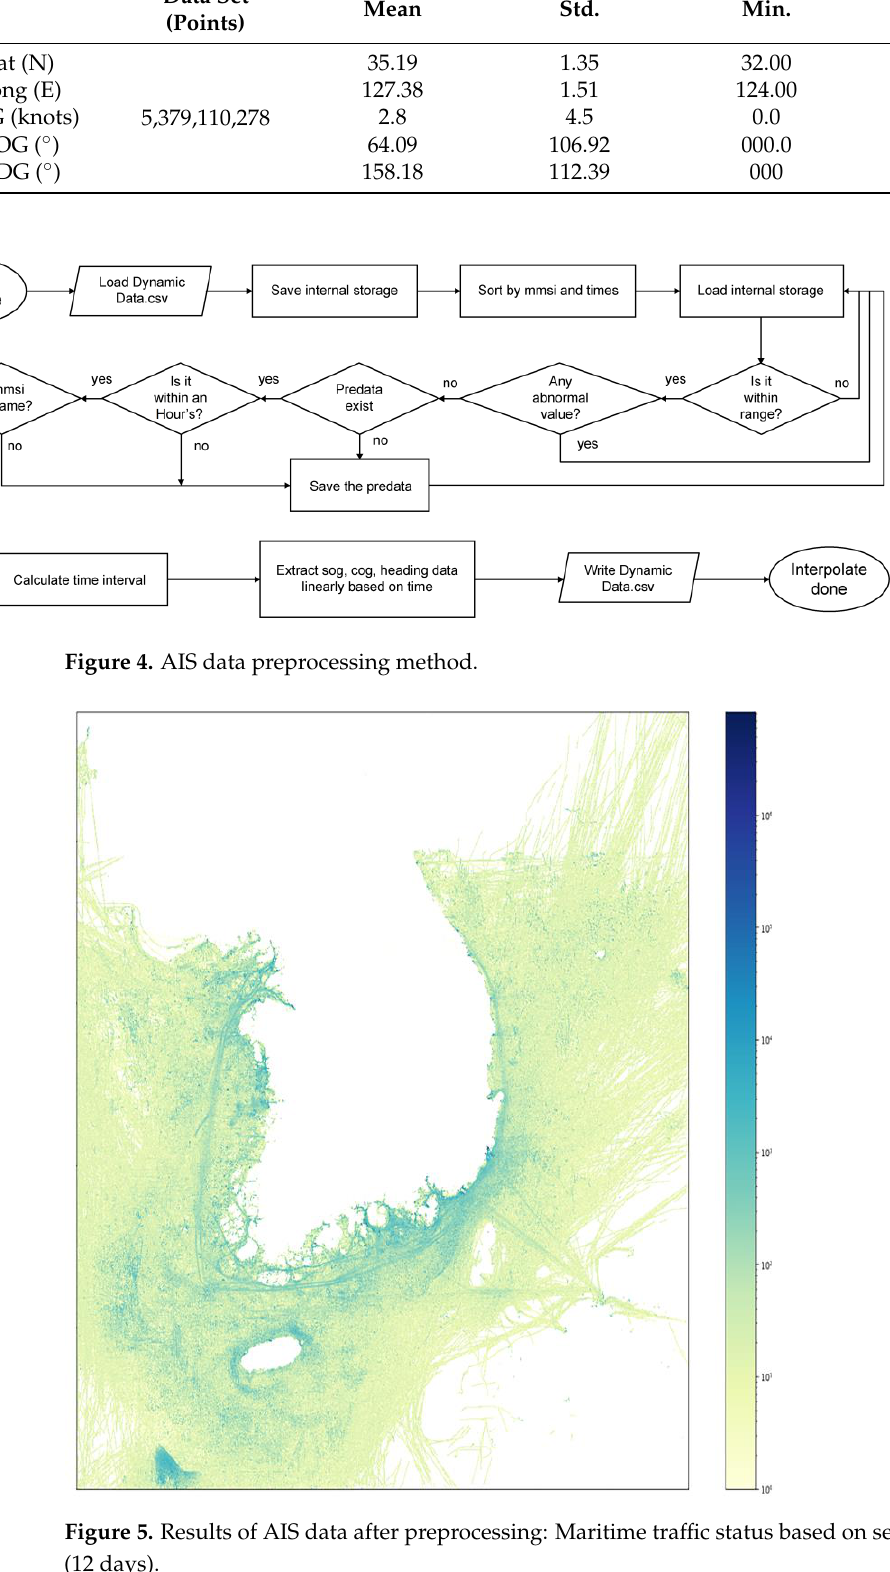
Figure 5. Results of AIS data after preprocessing: Maritime traffic status based on seasonal AIS data (12 days).